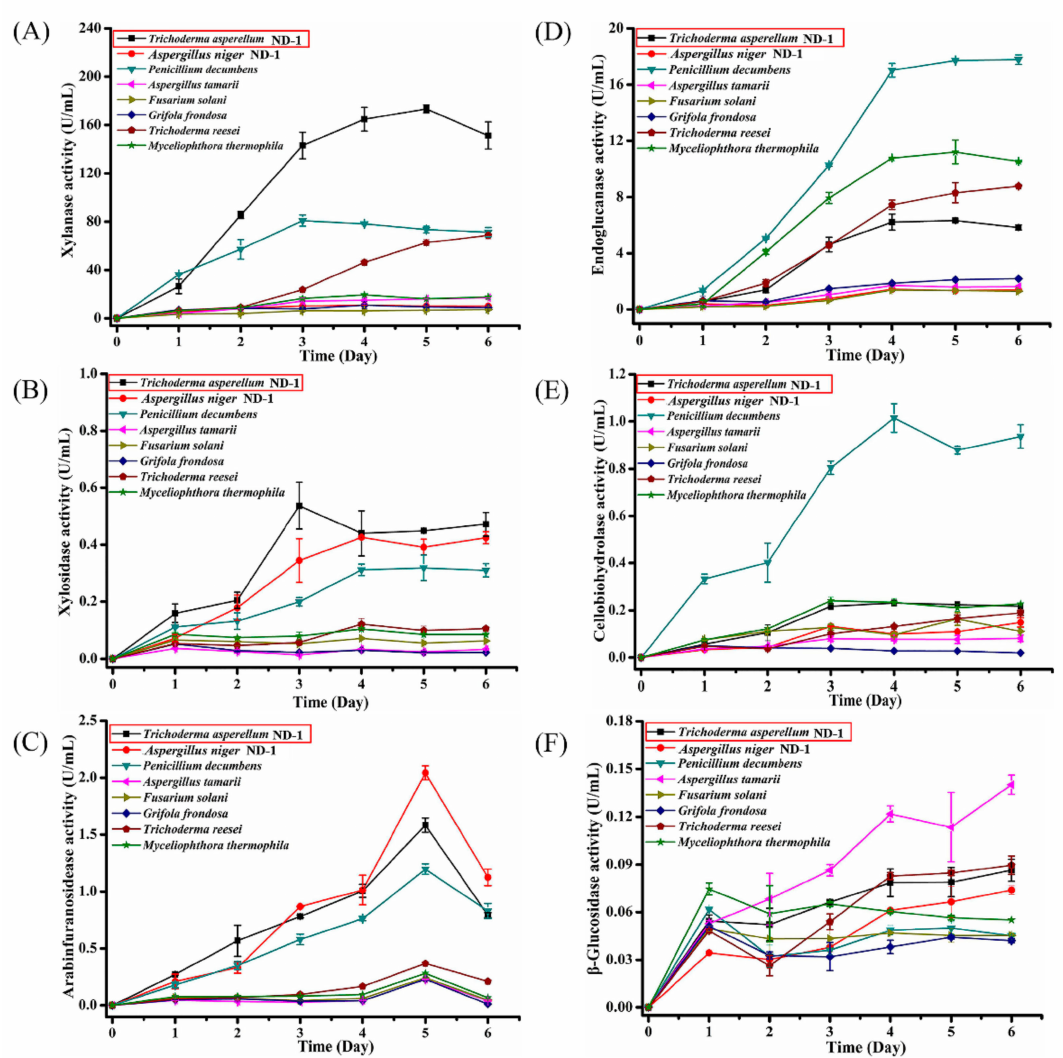
Figure 7. Comparison of lignocellulolytic enzyme activities produced by T . asperellum ND-1 and other fungi. The activities of hemicellulases (endoxylanase, β -xylosidase, and α -L- arabinofuranosidase) are shown in ( A – C ), respectively. The activities of cellulases (endoglucanase, cellobiohydrolase, and β -glucosidase) are shown in ( D – F ),